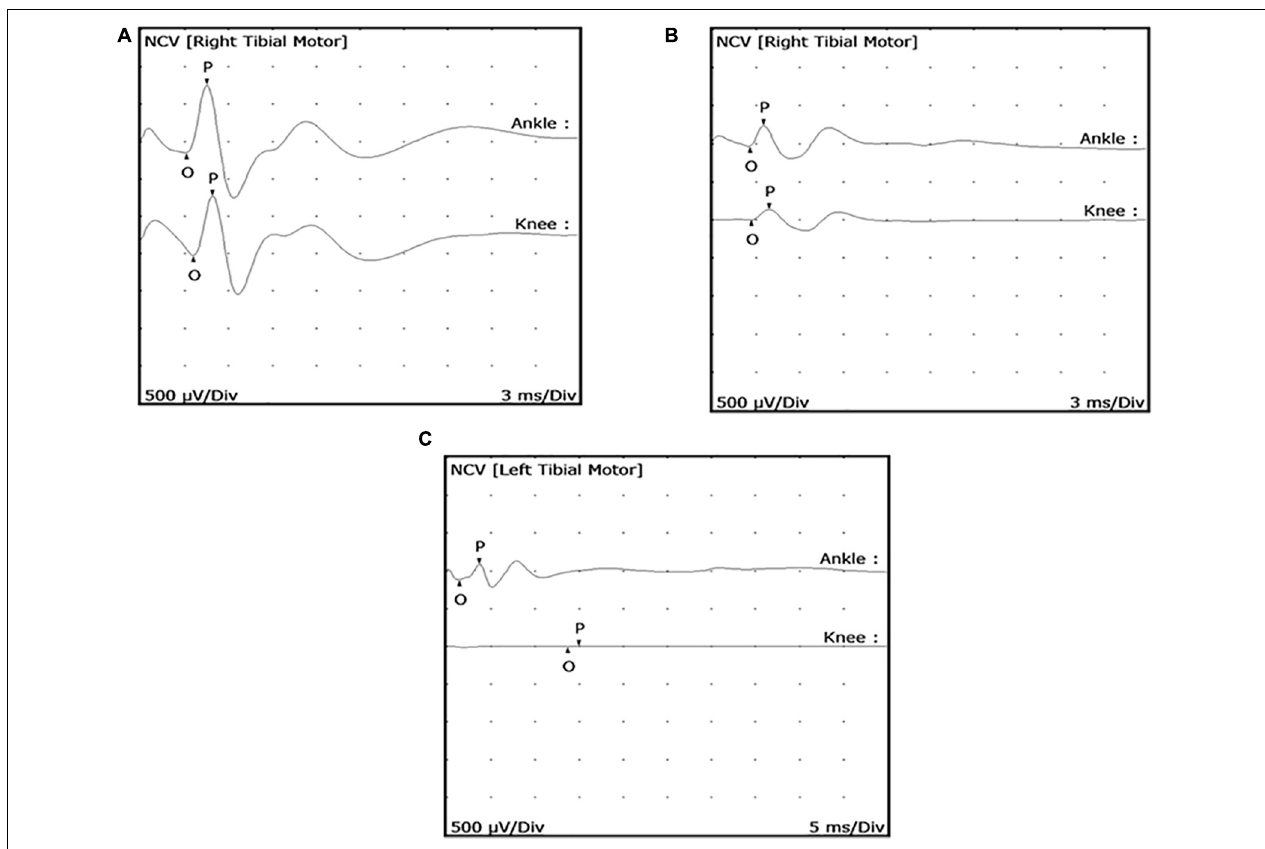
FIGURE 3 | Posterior tibial nerve conduction wave forms showing reduced compound muscle action potential (cMAP) in M. leprae -infected armadillos. MNCT were performed on the posterior tibial nerves of M. leprae- infected armadillos ( N = 71). Representative motor nerve conduction wave forms depict early (A) (4 months infection) and mid (B) (9 months infection) stage leprosy disease and show abnormal wave forms with declining degrees of cMAPs ( < 0.9 mV). Armadillos progressing to late stage leprosy disease (12–24 months post-inoculation), exhibit conduction block at the knee (C)